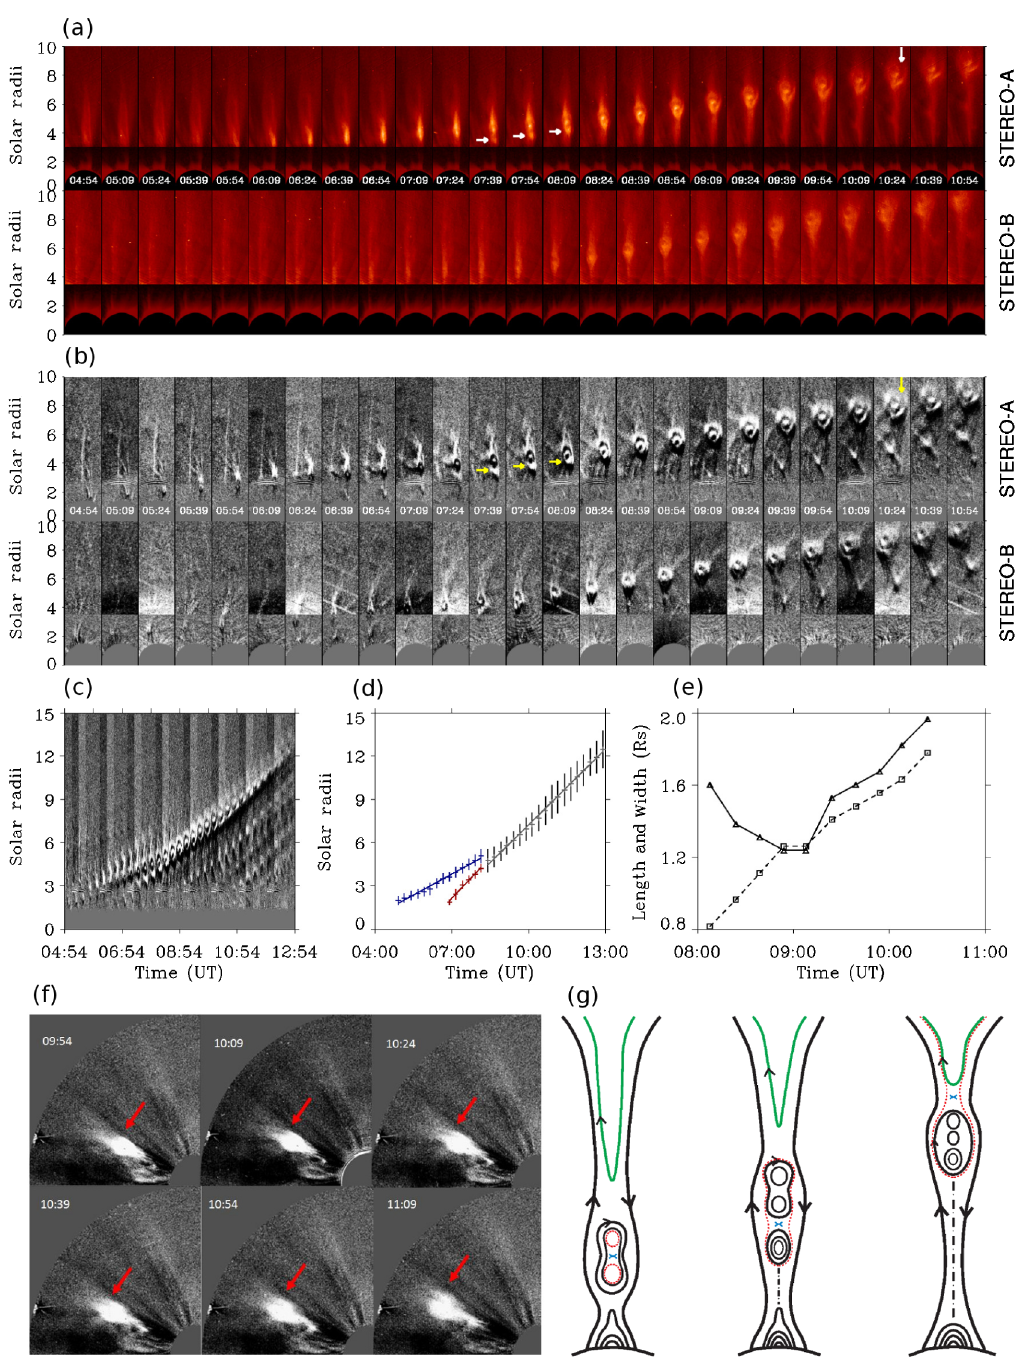
FIG. 2. (a),(b) The white-light and running-difference images of the magnetic blobs from STEREO-A and STEREO-B observations. The first blob evolved into a ‘‘two-core’’ peanut shape in the 07:39 frame. White arrows indicate the second blob moving and catching up to the first blob. Between 10:09 and 10:24, the upper right part of the blob appeared to open up (as indicated by the arrows), suggesting possible reconnection with the open magnetic-field lines lying above. (c) The running-difference image showing the merging process (left). (d) The height of the center of the blobs before and after they merge. (e) The length (solid line) and the width (dashed line) of the blobs during the merging phase. (f) The base-difference images showing the reconnection with the overlying magnetic field. The base image for these plots is from the frame with time 04:24. The opening-up phase is clearly seen from the 10:24 frame (and thereafter), although it is possible that it may have started in the 10:09 frame. (g) Drawings show the three reconnection processes in this event. Left: The breaking of the first blob into a two-core-peanut blob. Center: The merging of the two blobs. Right: The reconnection between the merged blob with the overlying magnetic field. Blue crosses mark the reconnection sites. Field lines before the reconnection are shown as black and green solid lines; field lines after the reconnection are shown as red dotted